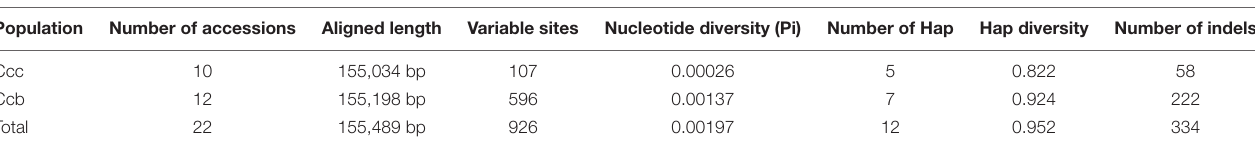
FIGURE 1 | Gene maps of the plastids of C. chinensis and C. deltoidea . The genes are color-coded based on their functions. The dashed area indicates the GC composition of the plastid. TABLE 1 | Chloroplast genome diversity of C. chinensis